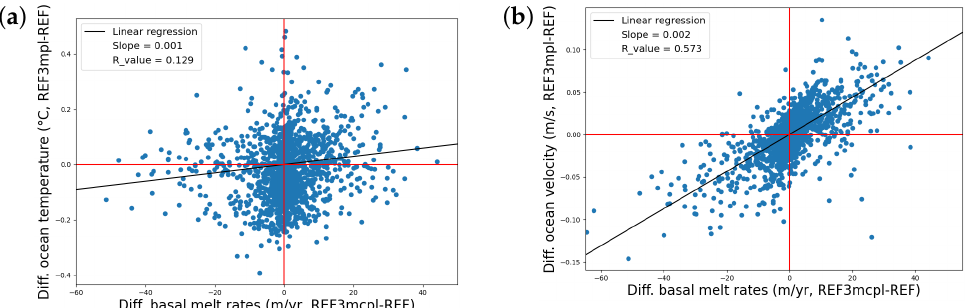
Figure 8. Scatter plots of the differences in basal melt rate between REF3mcpl and REF as function of the differences in ocean temperature ( a ) and the differences in ocean current speed ( b ). All differences between REF3mcpl and REF are computed over the 20-year simulation period. Both the ocean temperature and speed are taken in the first ocean layer beneath the